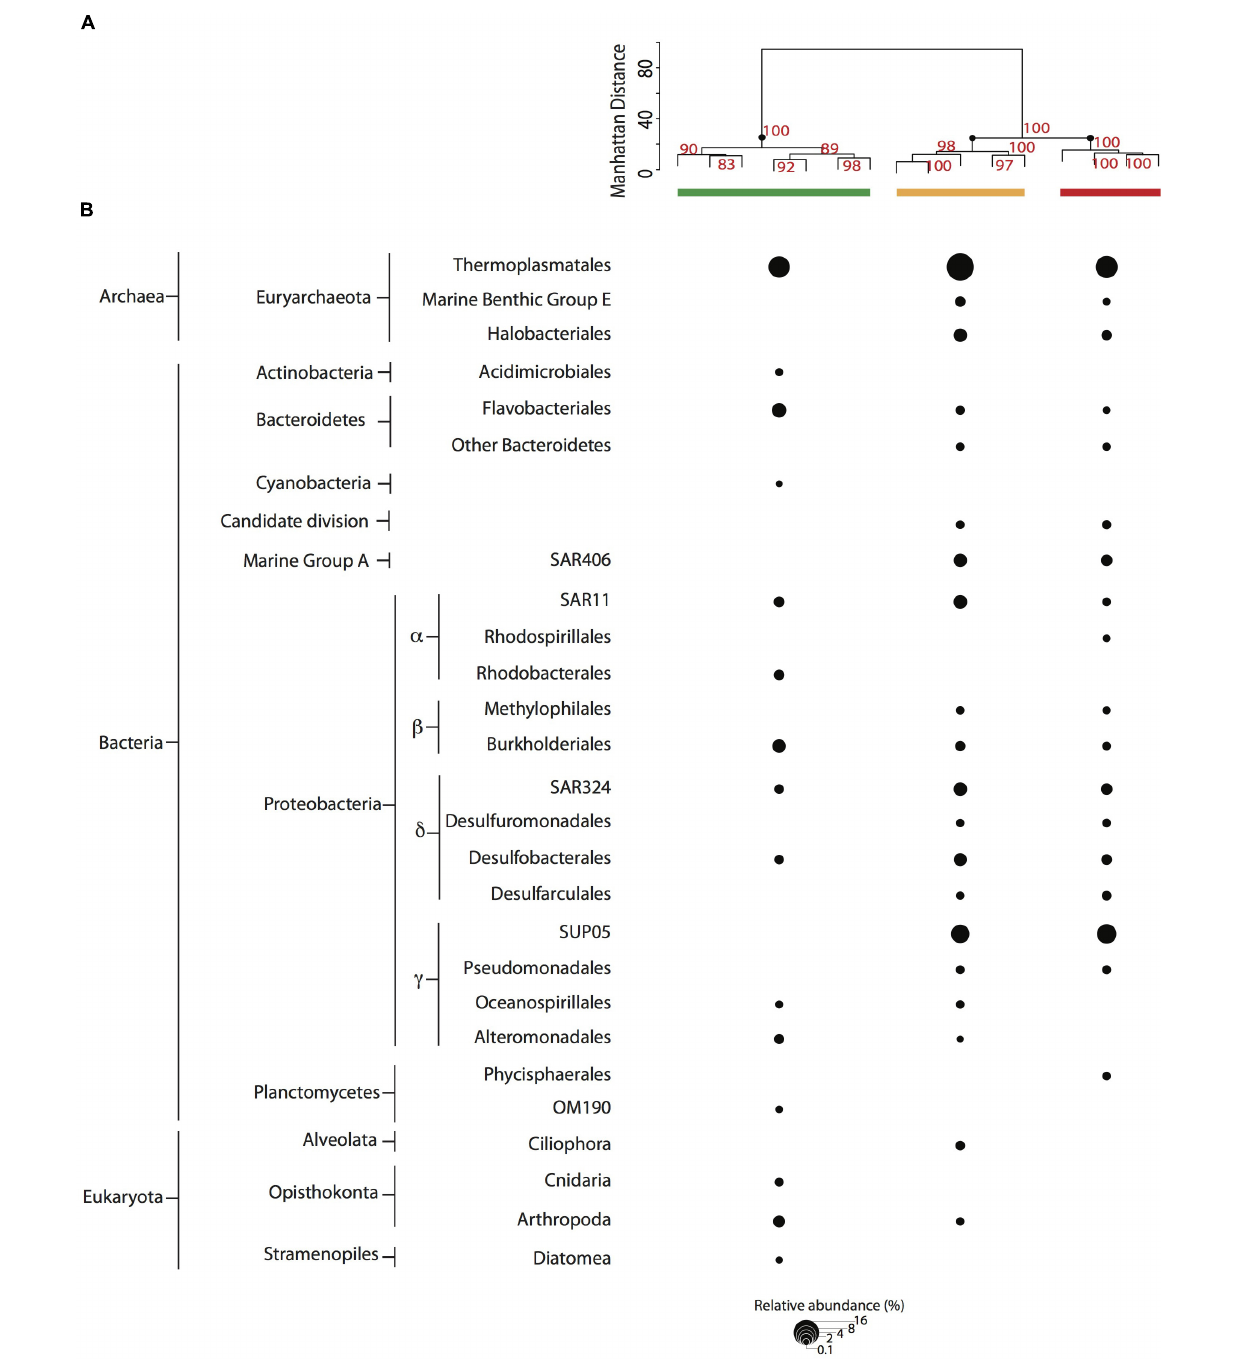
0.4 µ m filters increased fivefold compared to on-ship 0.22 µ m filters with in-line 0.4 µ m pre-filters and 0.4 µ m filters ( Figure 4